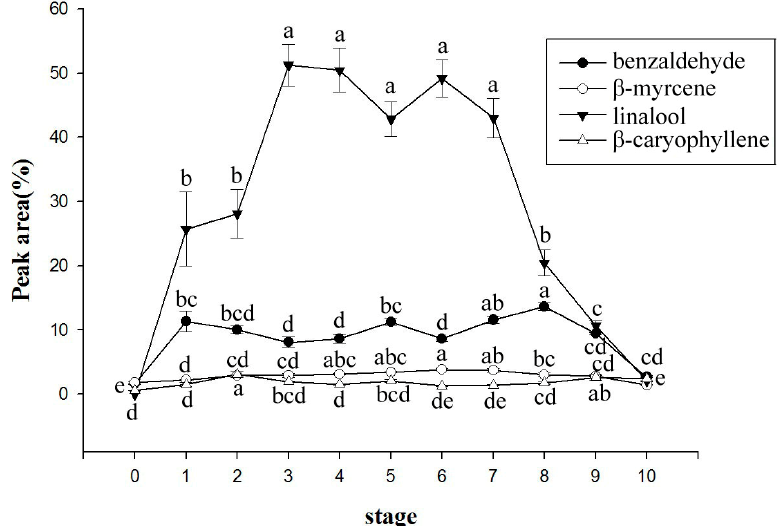
Figure 3. Changes in the major volatile components of Onc. Rosy Sunset during the flowering period (Different letters indicate significant differences at p < 0.05 by LSD multiple range).